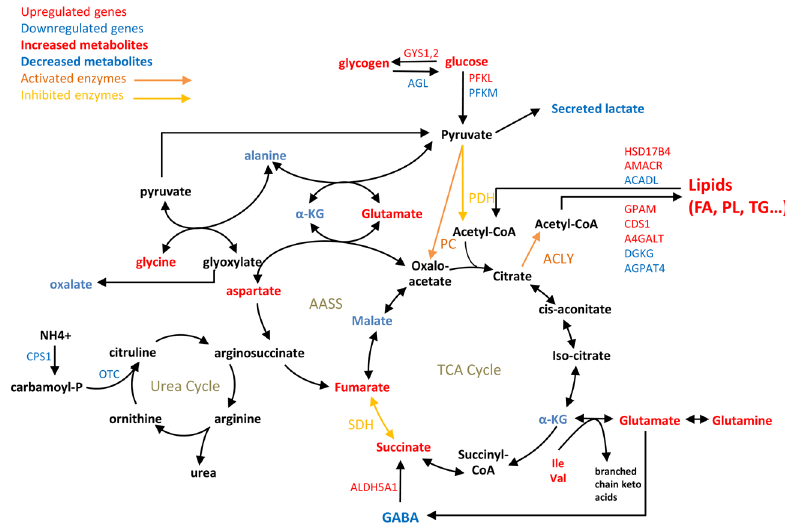
Fig. 7 Simpli fi ed scheme of central carbon metabolism and connected pathways showing differences between Huh7- GCK + /HK2 − vs Huh7. Highlighted metabolites, enzymatic activities, and metabolism-associated genes were selected from transcriptomic (Fig. 2e), metabolomic (Fig. 5c) and enzymatic analyses (Fig. 5f –